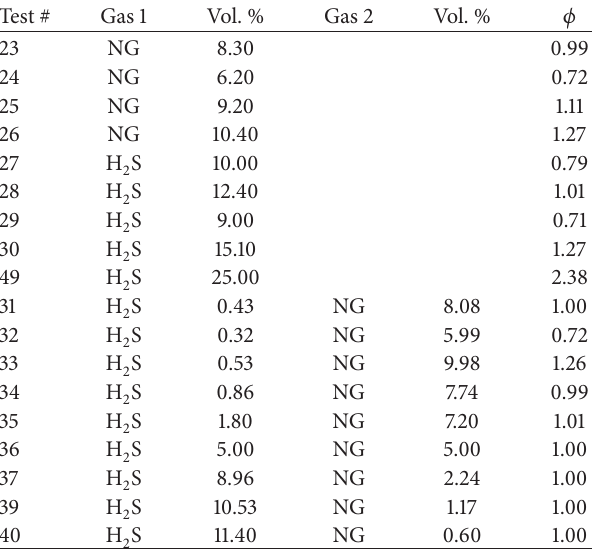
Table 1: Experimental